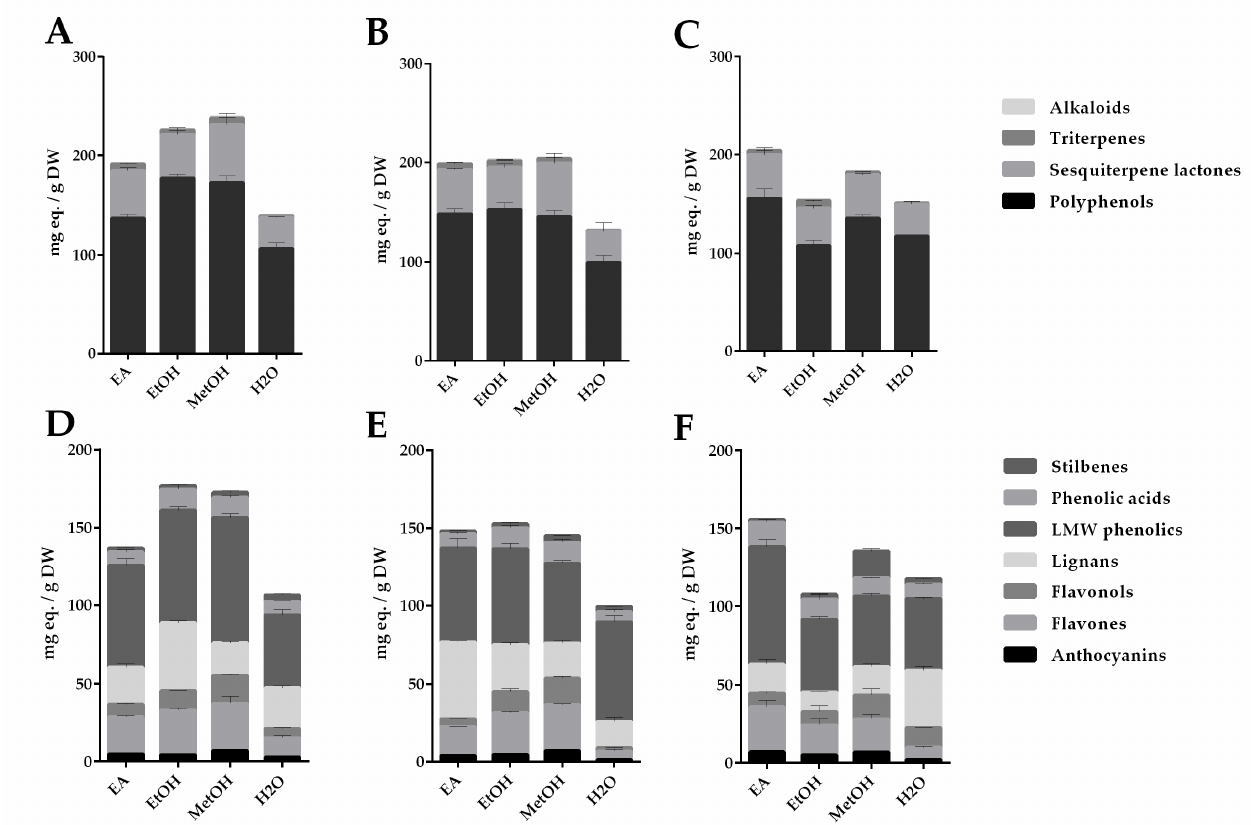
Figure 3. Cumulative graphs of R. angustifolius bioactive compounds classes. ( A – C ) reported the main classes of bioactive compounds, whereas ( D – F ) reported the main classes of polyphenols in R. angustifolius extracts. The letters correspond to: ( A , D ) = homogenizer-assisted extraction (HAE), ( B , E ) = maceration (MAC), and ( C , F ) = Soxhlet (SOX) methods of extraction.